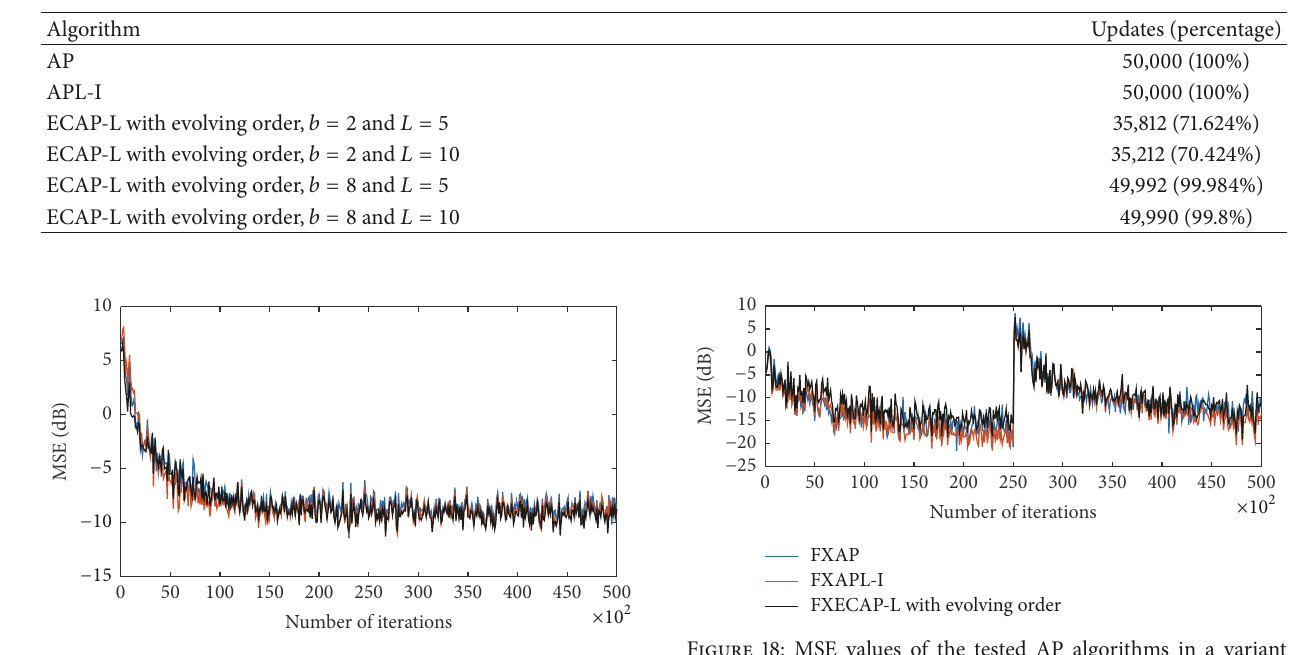
Table 5: Numbers of updates and update percentages for the multichannel ANC system.